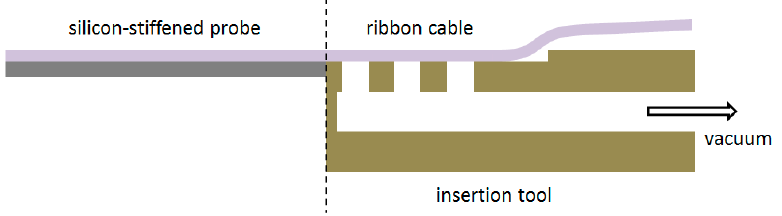
Figure 5. Schematic diagram showing the principle fixation of the floating probe using the vacuum-actuated insertion tool.